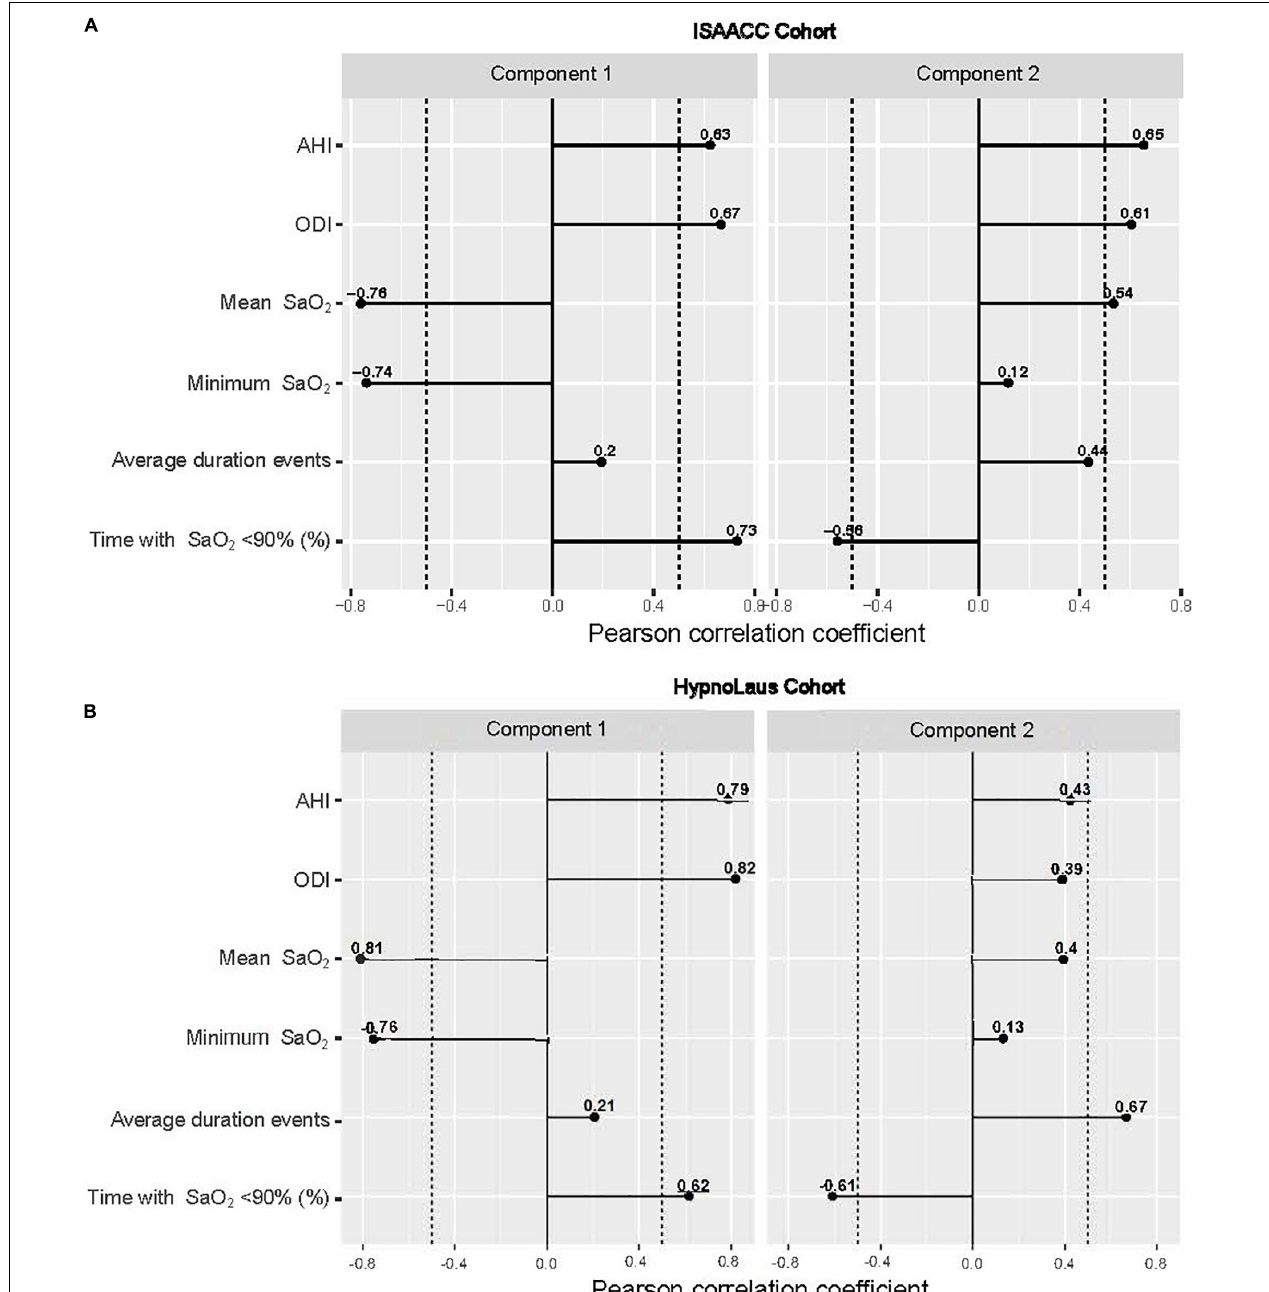
FIGURE 2 | Correlations between respiratory polygraphy parameters and components derived from the PCA. (A) In the ISAACC cohort, these two components, component 1 and component 2, accounted for 43 and 26% of the total variance, respectively. (B) In HypnoLaus, these two components, component 1 and component 2, accounted for 49.2 and 22.1% of the total variance, respectively. AHI, apnea-hypopnea index; ODI, oxygen desaturation index; and SaO 2 , oxygen saturation. Dashed lines represent –0.5 and 0.5